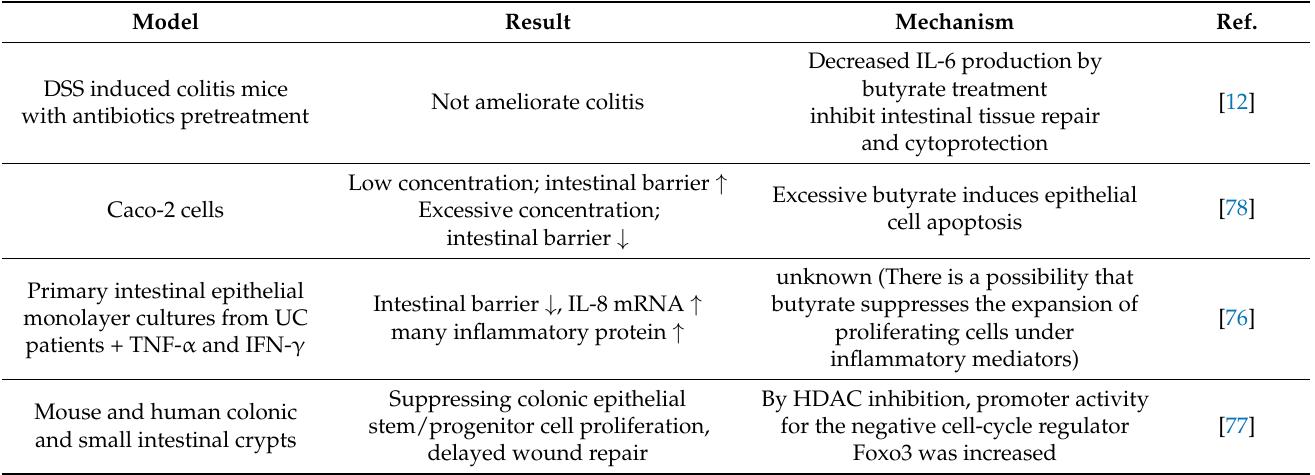
Table 3. Research showing negative effects of butyrate on barrier function and